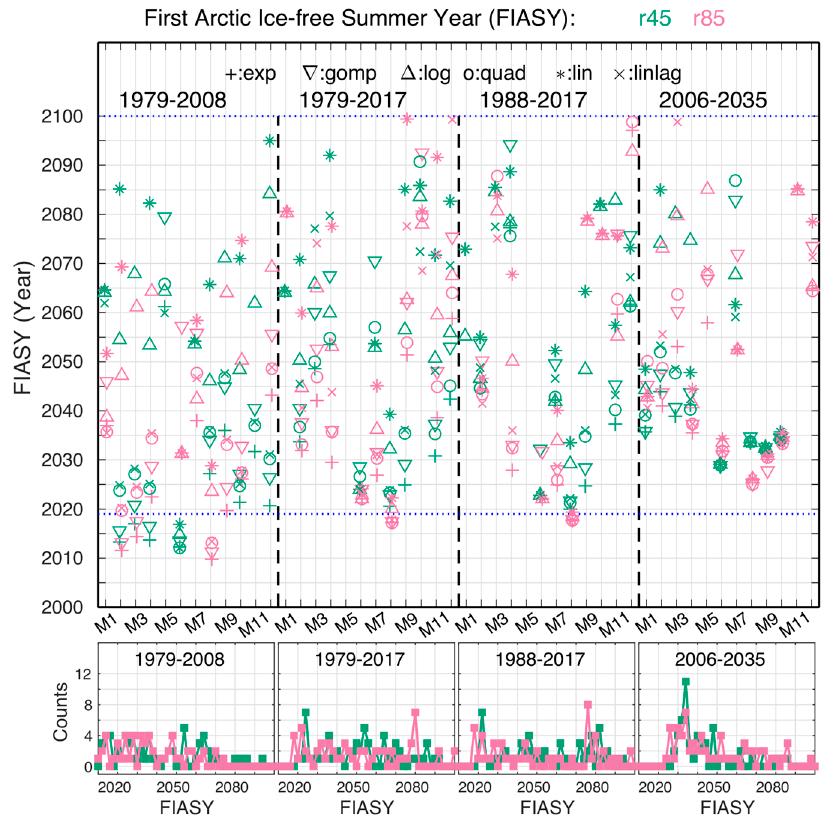
Figure 8. Top panel: the FIASYs predicted by the six curve-fitting models for each of the 12 climate models for the four considered periods, separated by the dashed vertical lines. Horizontal dotted line denotes the current year 2019. Bottom panel: the occurrence of predicted FIASYs from all six statistical models within each two-year bin. FIASY values later than 2100 are not included in the diagram. Green / pink colors indicate the r45 / r85 scenarios, respectively. The shapes denote the types of curve-fitting models, as described by the legend of the top panel.